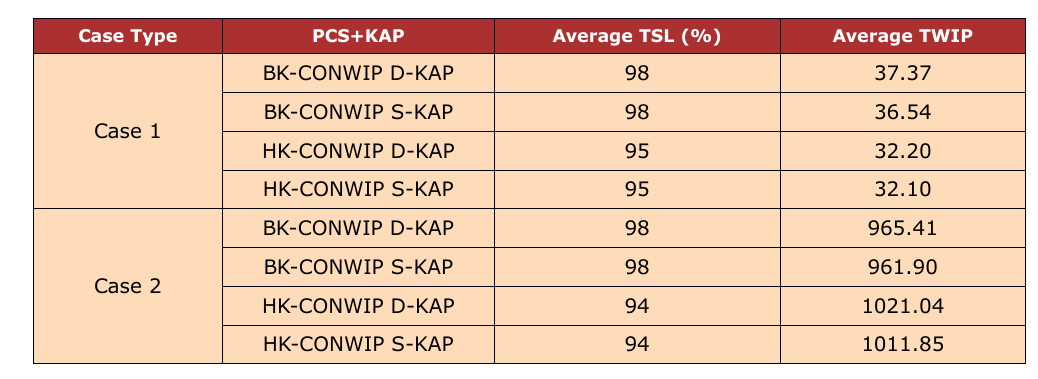
Table 7. Performance metrics achievable at low WIP